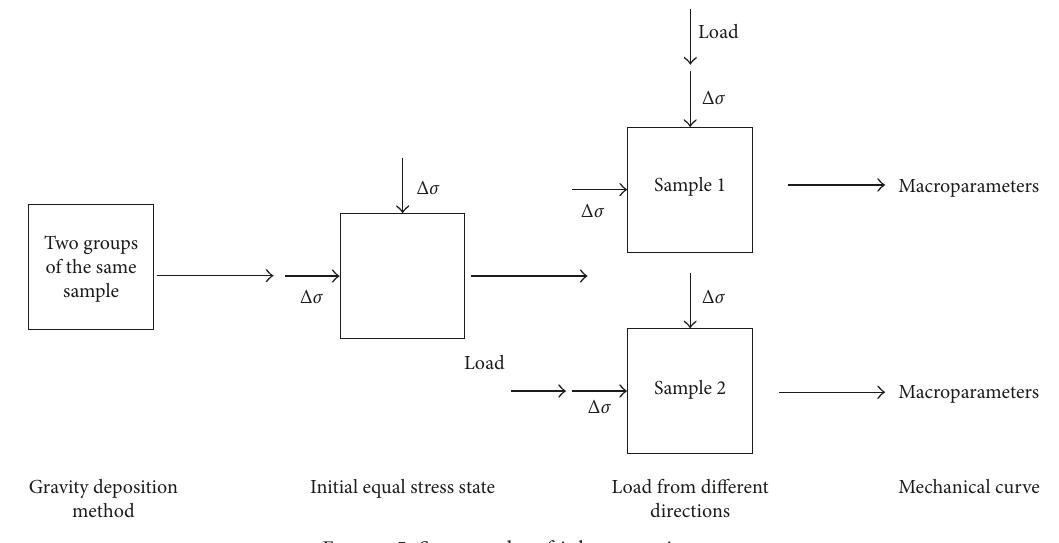
Figure 5: Stress paths of inherent anisotropy. Table 6: Sample number and load